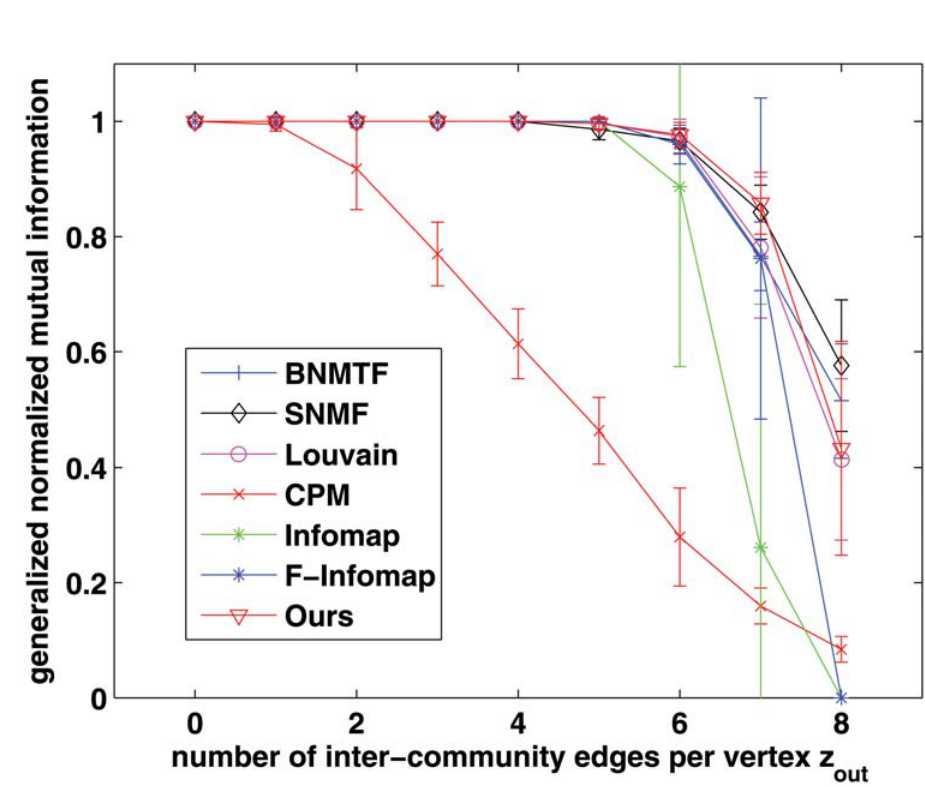
Fig 3. Evaluation of different methods on Newman ’ s benchmark networks in terms of GNMI.